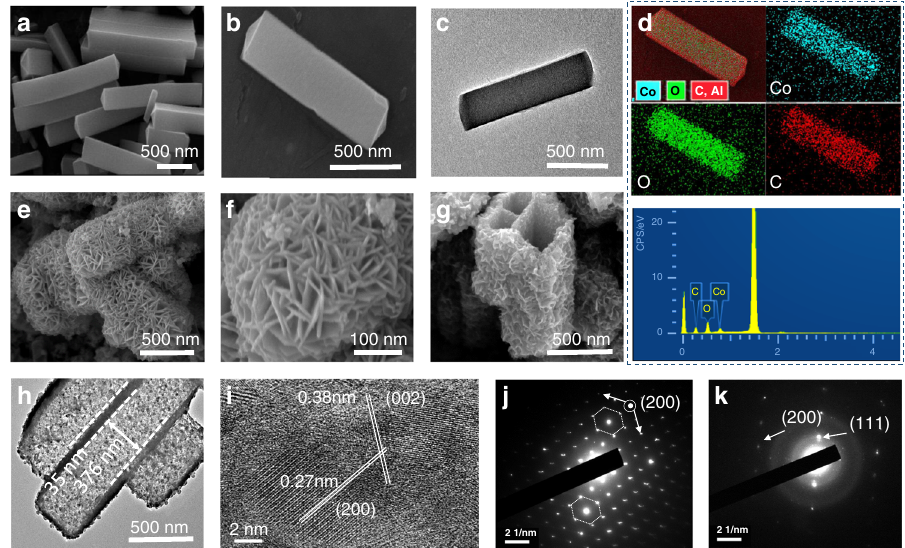
Fig. 2 Illustration and characterization of bipyramid like prisms of co-precursor. a , b FESEM images. c TEM image and d EDS elemental mapping of co- precursor. e , f FESEM images of BPCO. g FESEM image. h Low-resolution TEM image. i High-resolution TEM image and j , k SAED patterns of BPCS.